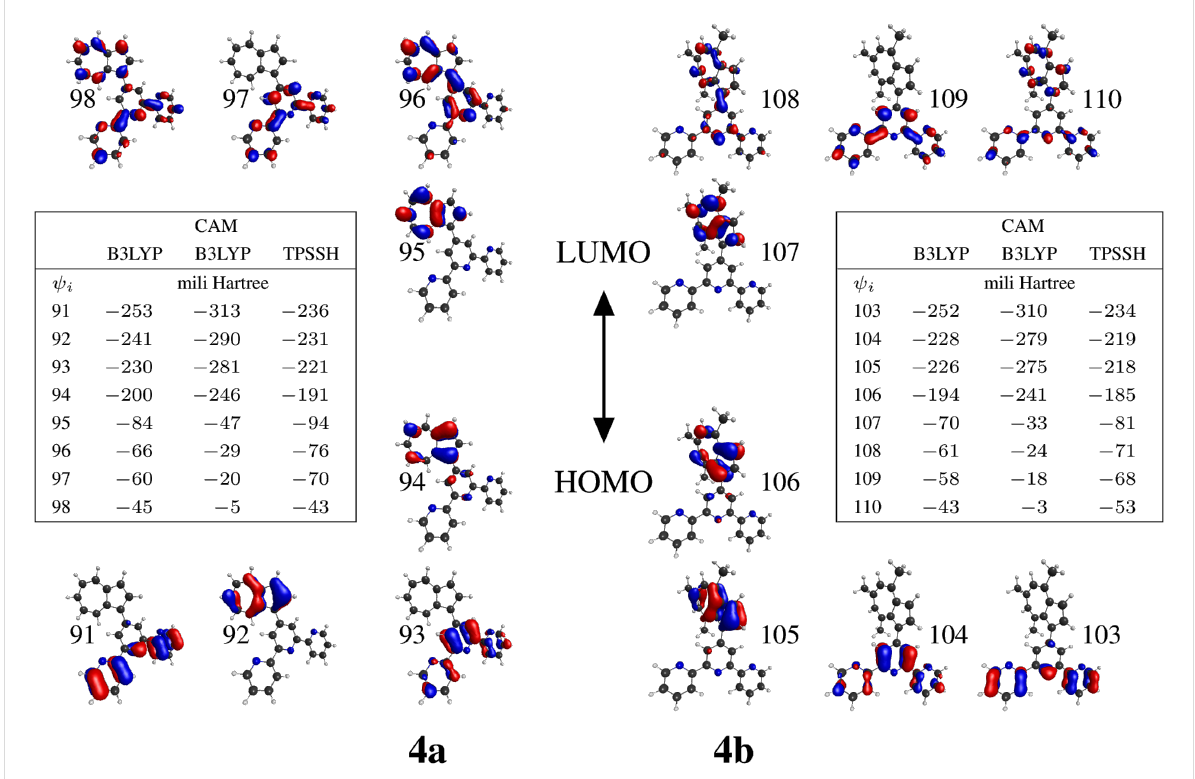
Figure 6: Selected Kohn–Sham orbitals and orbital energies for 4a and 4b , obtained with three different functionals and 6-311+G(d,p) basis.